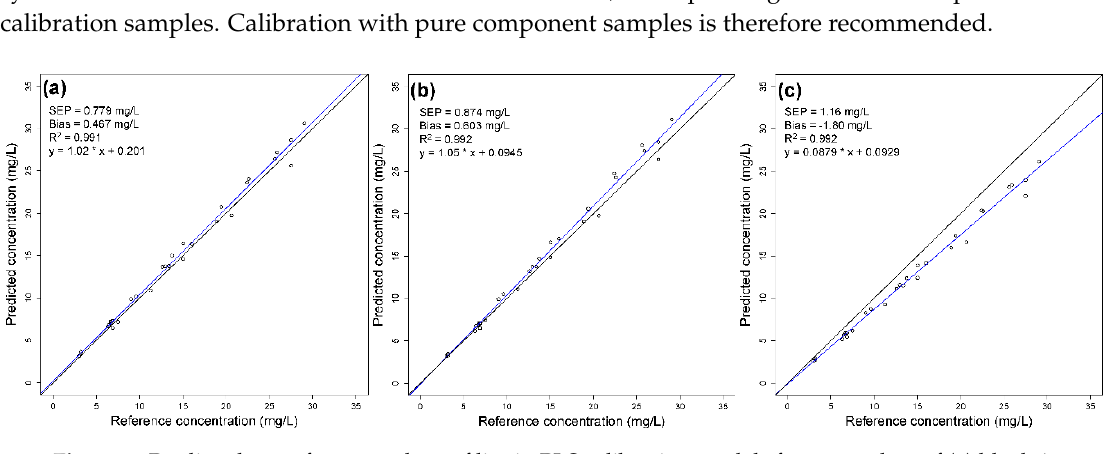
Figure 7. Predicted vs. reference values of lignin PLS calibration models from raw data of ( a ) block 1, ( b ) block 2, and ( c ) block (3) applied to data block 4. The regression line is in a blue color, and the 45° line is shown in black.